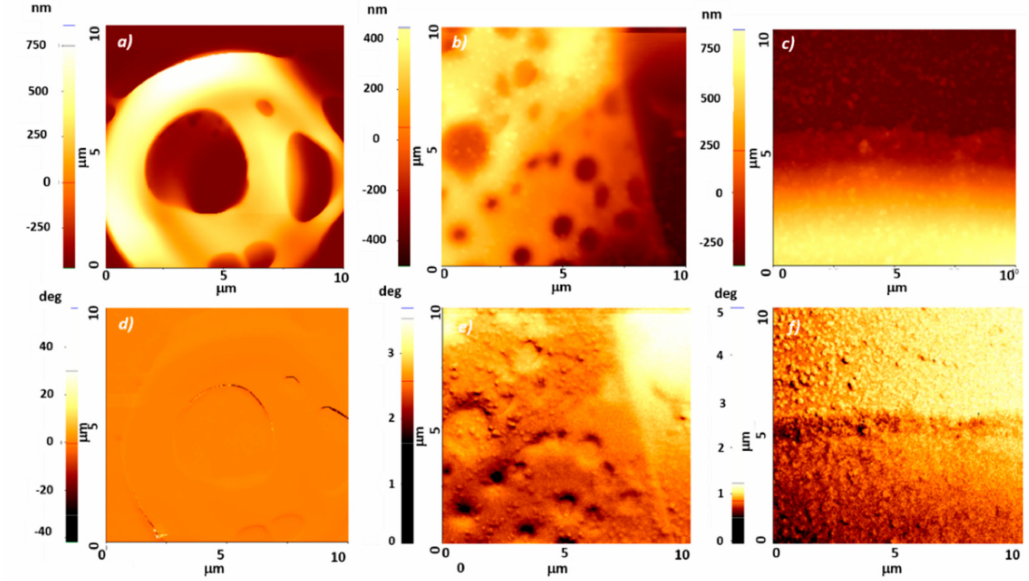
Figure 5. Topographical (upper panel) and magnetic force microscopy (lower panel) images of sca ff olds